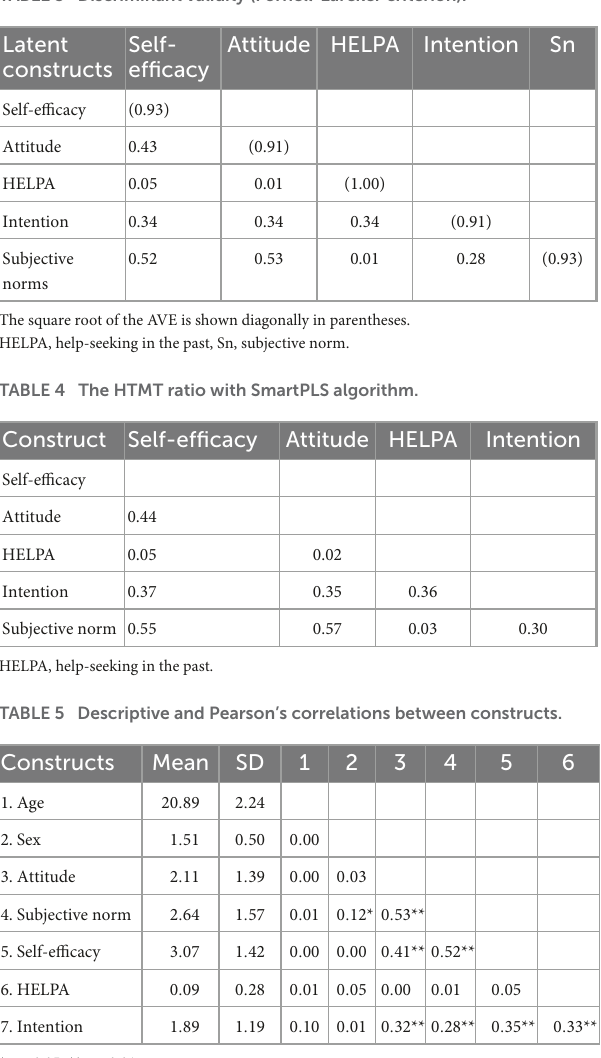
TABLE 2 Factor loadings and reliability. TABLE 3 Discriminant validity (Fornell-Larcker criterion).